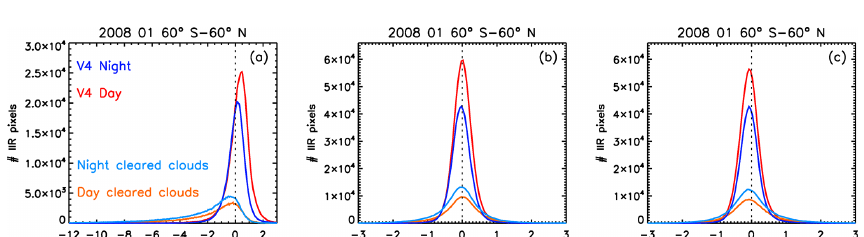
Figure 4. Same as Fig. 3 but for July 2006.